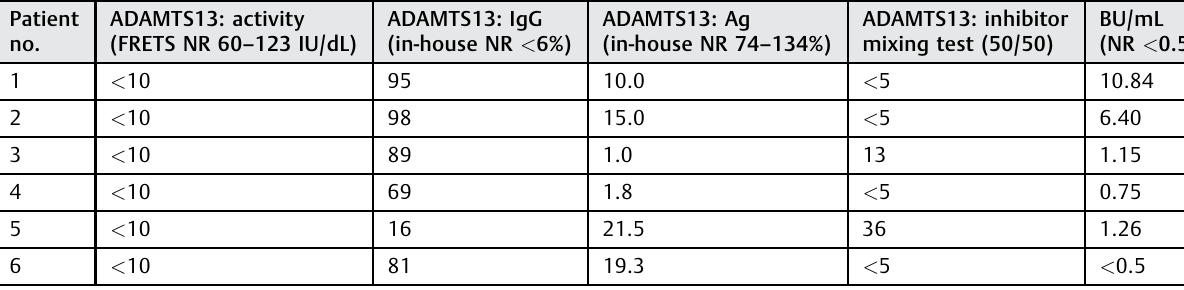
Table 2 ADAMTS13-related variables in six patients with immune-mediated TTP